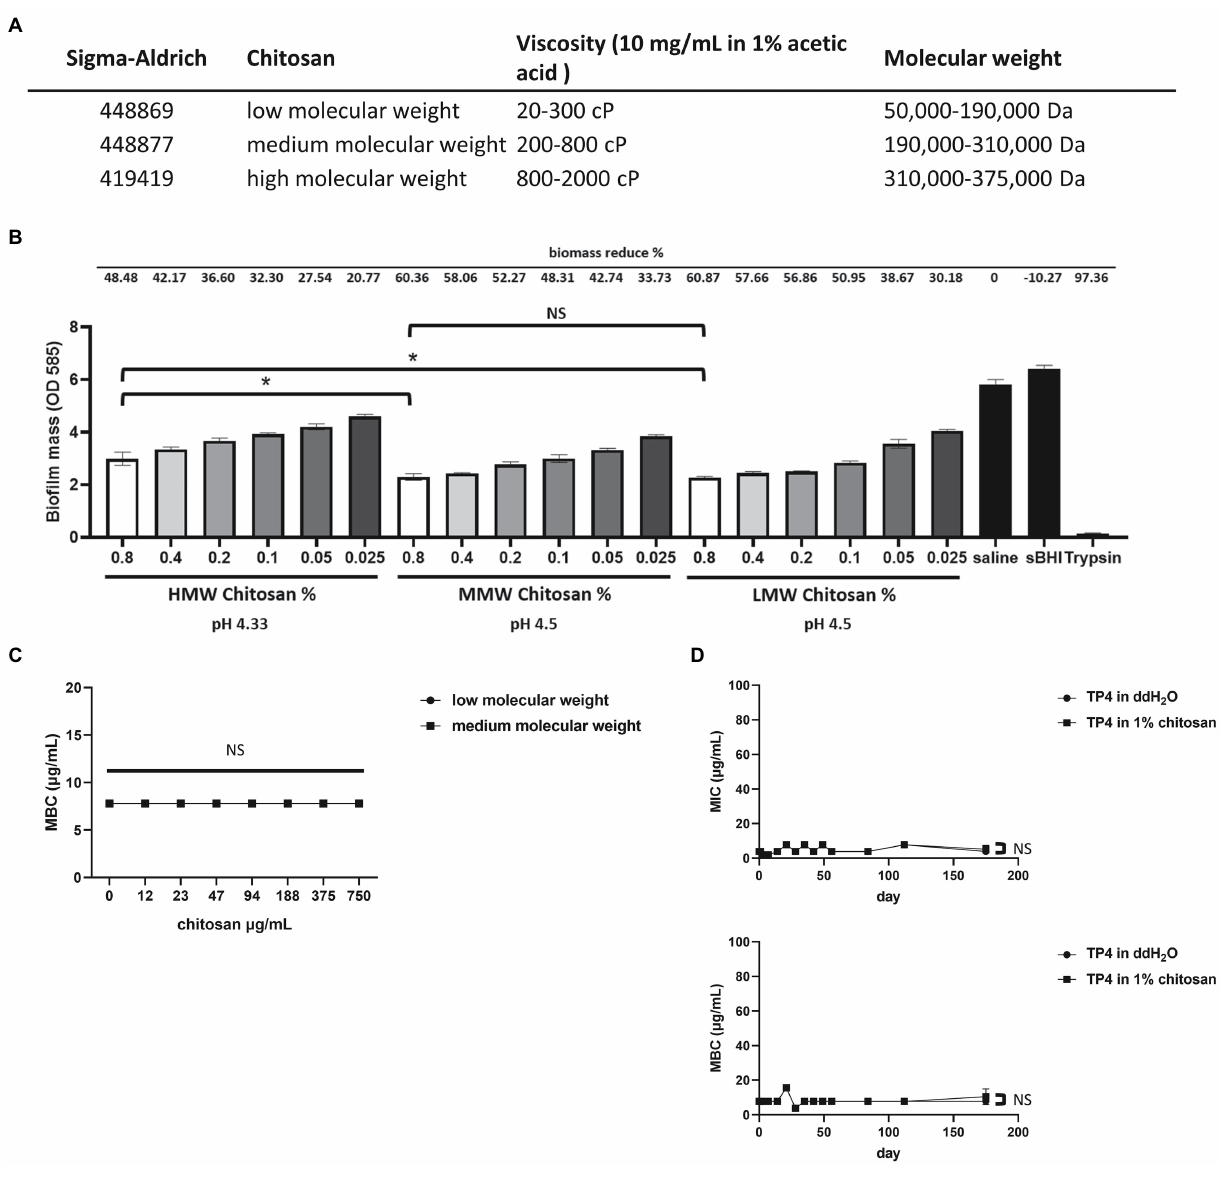
FIGURE 5 | Chitosan can disrupt G. vaginalis biofilm and does not affect TP4 bactericidal activity. (A) Different molecular weights of chitosan were used. (B) Testing the biofilm disruption activity of different molecular weights of chitosan. Different molecular weights of chitosan were added to Gardnerella vaginalis biofilms at different concentrations. Saline served as a vehicle control; sBHI served as a negative control; trypsin served as a positive control. Biofilm mass was determined by crystal violet staining. Data show the quantified biofilm mass and average biomass reduction (%) from three individual experiments. (C) TP4 bactericidal activity in Brain-Heart Infusion glucose (BHIG) with different concentrations of low molecular weight (LMW) and medium molecular weight (MMW) chitosan. (D) Long-term stability of TP4 stored in chitosan gel was analyzed over time. TP4 was dissolved in chitosan gel or ddH 2 O. MICs and MBCs were determined at different time- points. All values represent the mean ± SD of three individual experiments (* p < 0.05, one-way ANOVA). NS, no significant